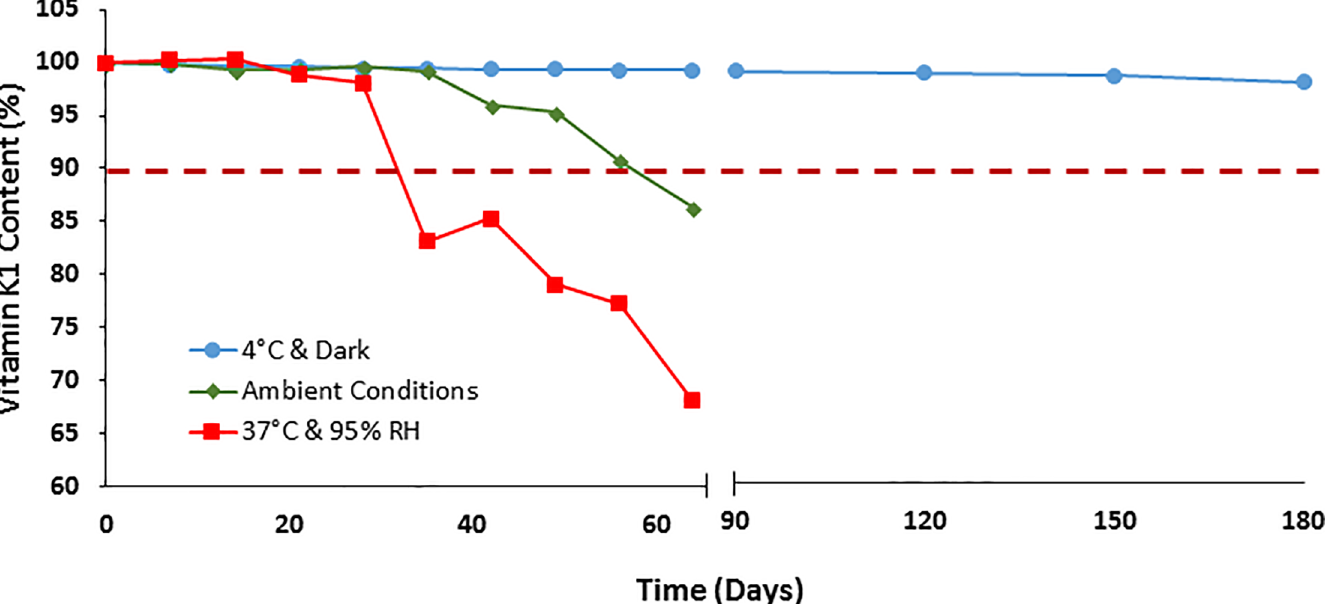
Fig 4. Chemical stability. The phytonadione content in different storage conditions versus time. The red dotted line represents the 90% lower limit, specified by USP for vitamin K1 injectable emulsion.